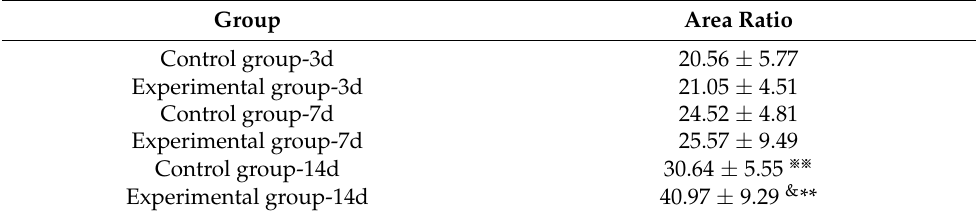
Figure 7. HE staining results. Table 5. Area ratio occupied by collagen.